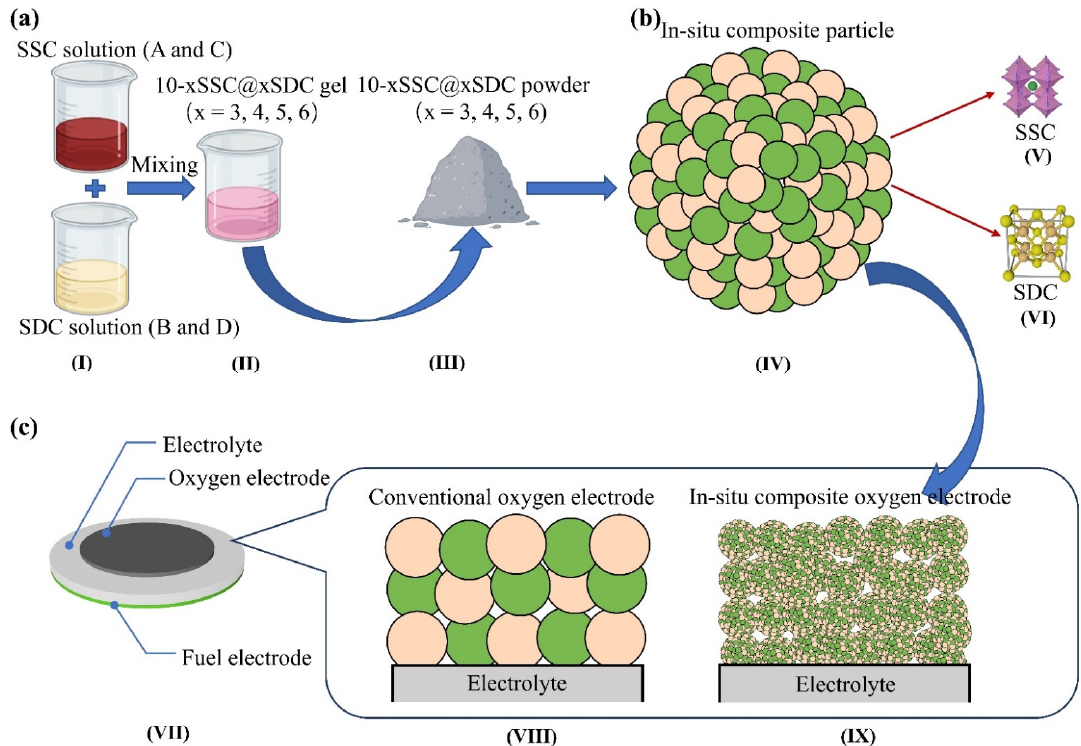
Figure 1. ( a ) Schematics of fabricating process of 10-xSSC@xSDC (x = 3, 4, 5, 6) by in-situ